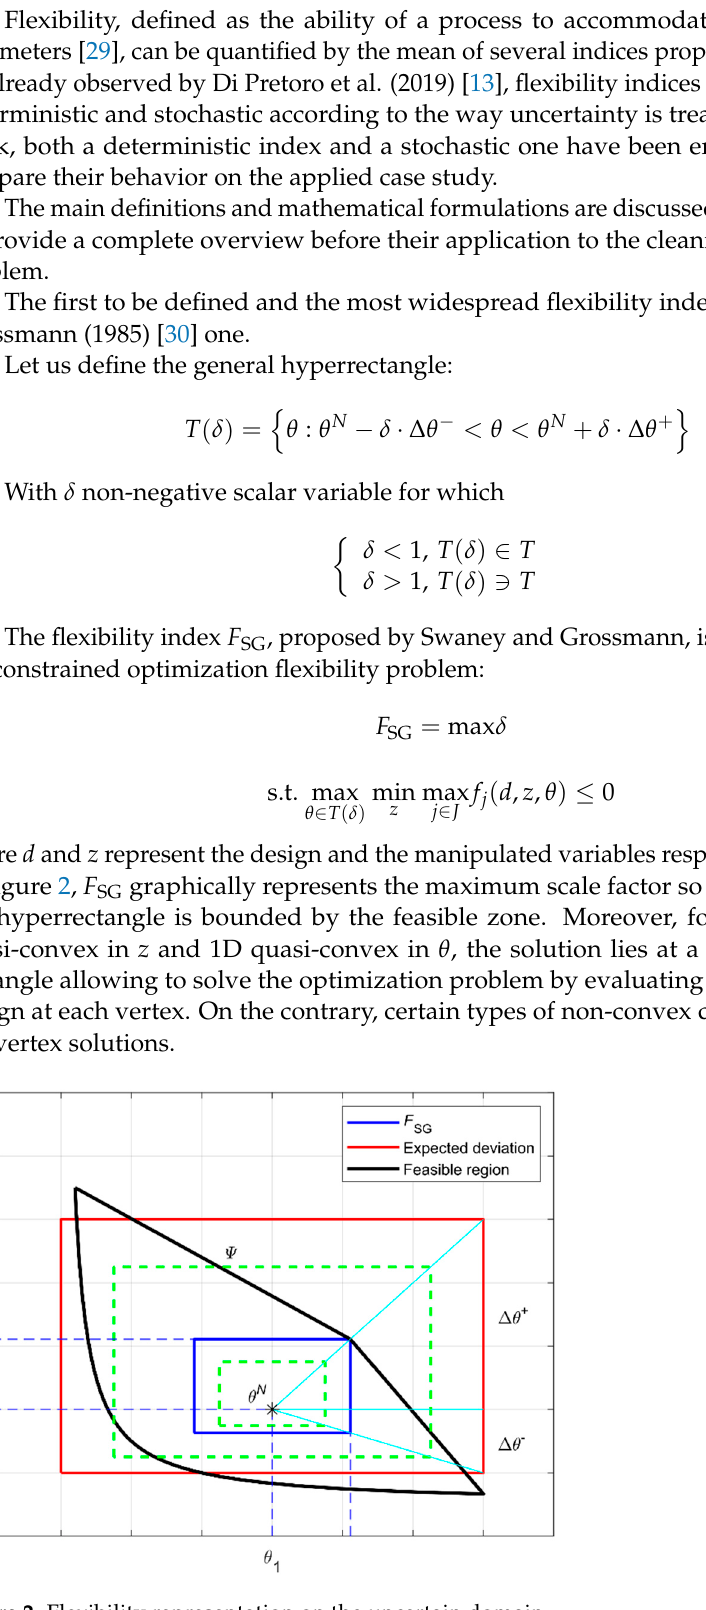
Figure 2. Flexibility representation on the uncertain domain.